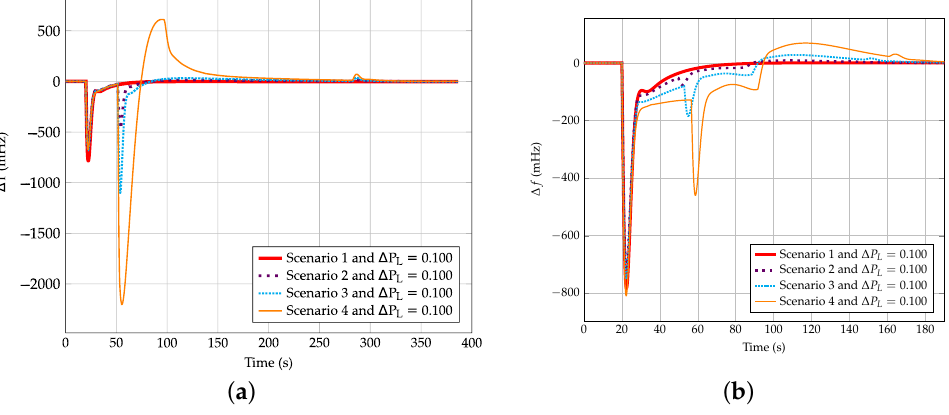
Figure 17. Comparison between frequency excursion for scenarios 1–4 including wind power plant controls and considering ∆ P L = 0.100. ( a ) Controller from [23]; ( b ) Proposed control with x =